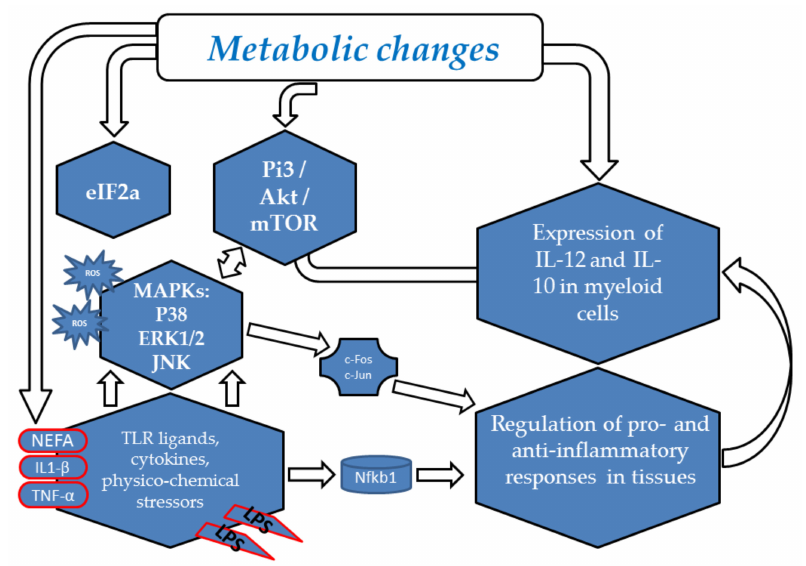
Figure 2. Metabolic stress is perceived by the innate immune system. The Pi3 / Akt / mTOR- and eIF2 α -dependent signal transduction cascades are the main signaling pathways monitoring nutrient availability and controlling metabolic stress responses. Toll-like receptors (TLRs) are expressed on innate immune cells, such as neutrophils, macrophages, and dendritic cells, and respond to the membrane components of Gram-positive or Gram-negative bacteria and to saturated free fatty acids mainly included in the NEFA (Non-esterified Fatty Acid) that are released by adipose tissue during status of negative energy balance. TLRs provoke rapid activation of innate immunity by inducing production of proinflammatory cytokines and upregulation of costimulatory molecules by both MAPK activation, which in turn activates c-Fos and c-Jun, and NF-kappa B activation through a MyD88-independent pathway. In addition, interleukin-1 β (IL1- β ) and tumor necrosis factor alpha (TNF- α ), as critical cytokines, can induce a wide range of intracellular signal pathways as well as inflammation and immunity as nearly all cells express the respective